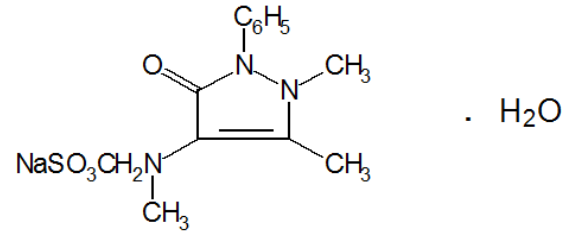
Figure 1. Molecular structure of